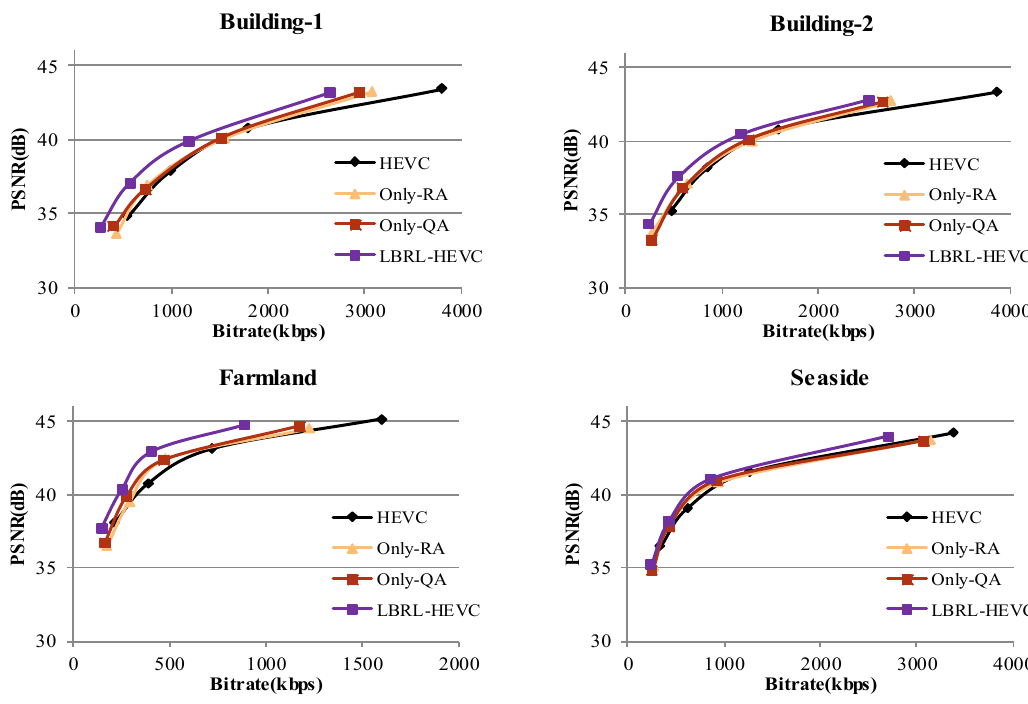
Figure 9. RD curves of HEVC , Only-RA , Only-QA , and LBRL-HEVC from four satellite video clips.